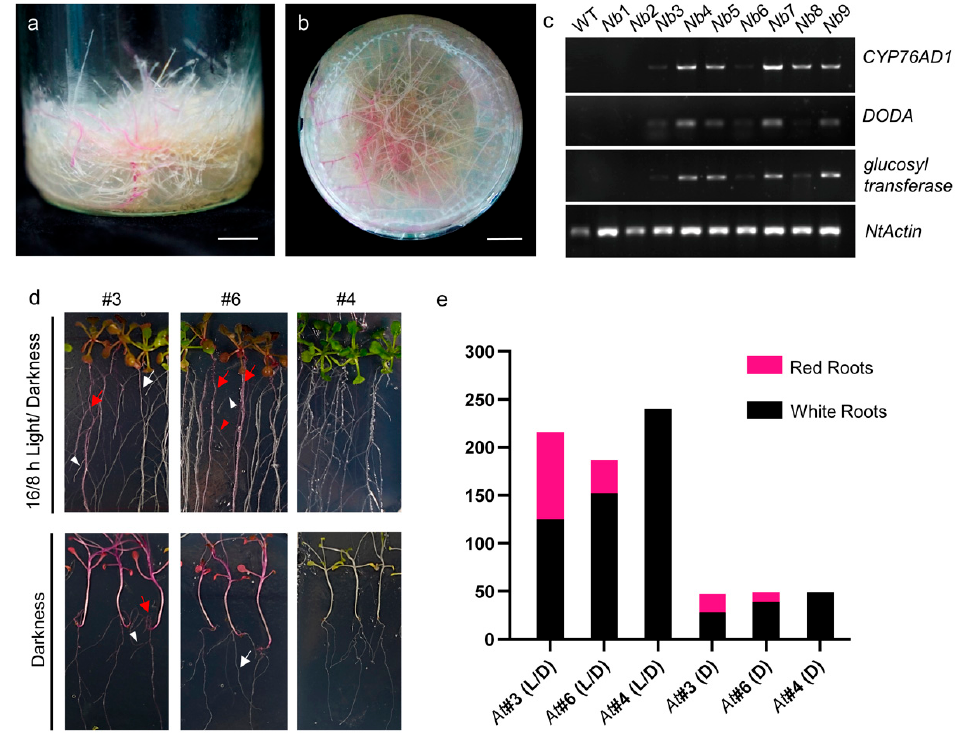
Figure 4. Analysis of the red coloration rate of overexpressed RUBY in N. benthamiana hairy